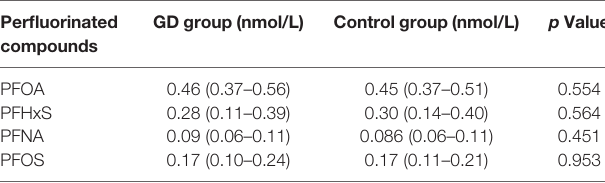
TABLE 6 | Per fl uorinated compounds between GD and control groups.